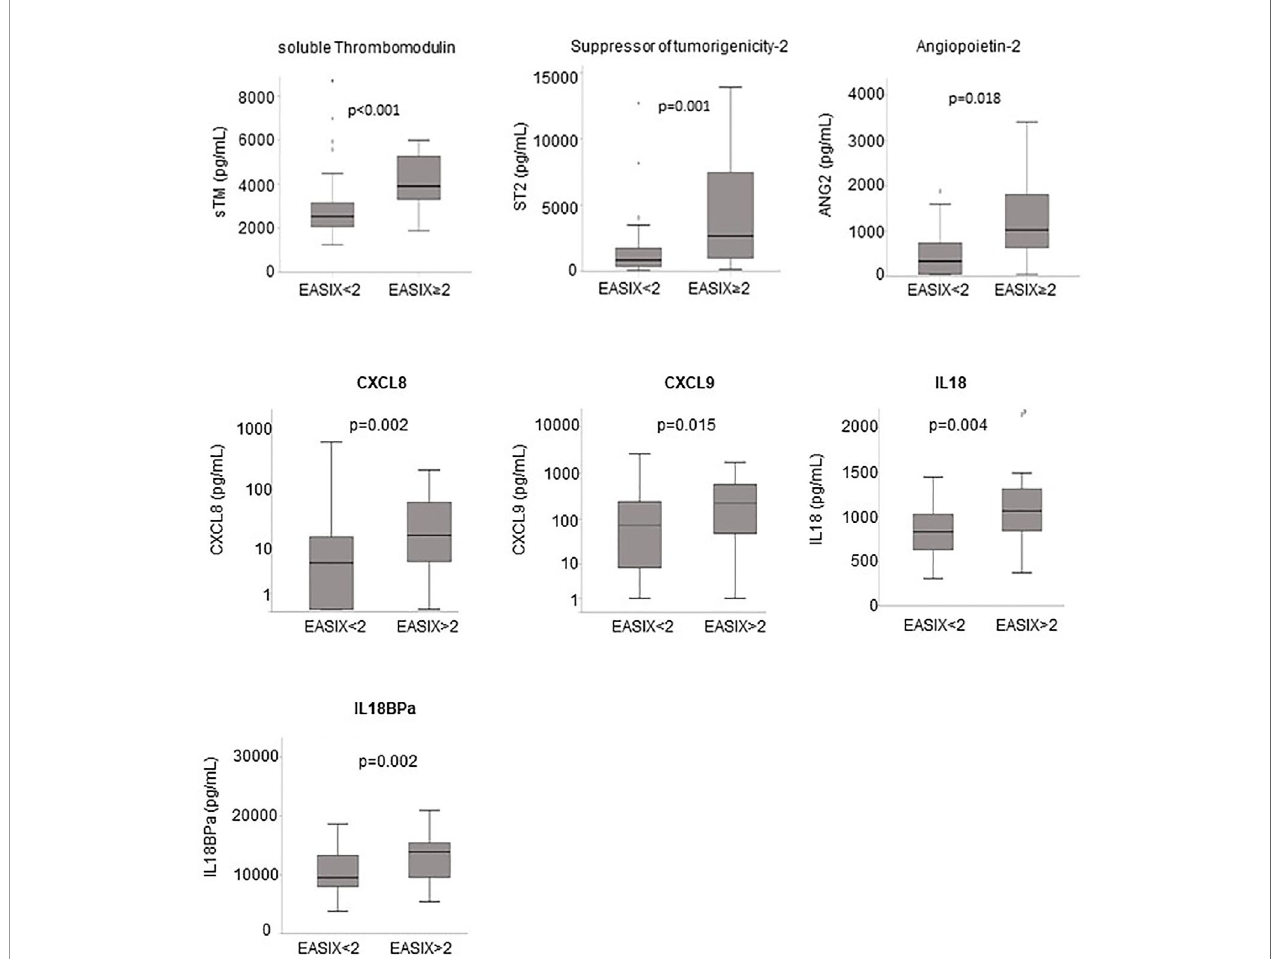
FIGURE 2 | Endothelial markers and EASIX. Boxplots of serum levels of endothelial markers according to the EASIX cut-off: angiopoietin-2 (ANG2), suppressor of tumorigenicity-2 (ST2), soluble thrombomodulin (sTM), CXCL8 (interleukin-8), CXCL9 (monokine induced by gamma interferon, MIG), interleukin-18 (IL18) and IL18 binding protein A (IL18BPa). P-values for Kruskal-Wallis tests, n=87. Spearman-rho correlation coef fi cients with EASIX as continuous variable (n=87): ANG2 0.355, p < 0.001; sCD141 0.397, p < 0.001; ST2 0.397, p < 0.001; CXCL8 0.347, p < 0.001; IL-18 0.318, p=0.003; IL18BPa 0.260, p=0.015, CXCL9 0.453, p <